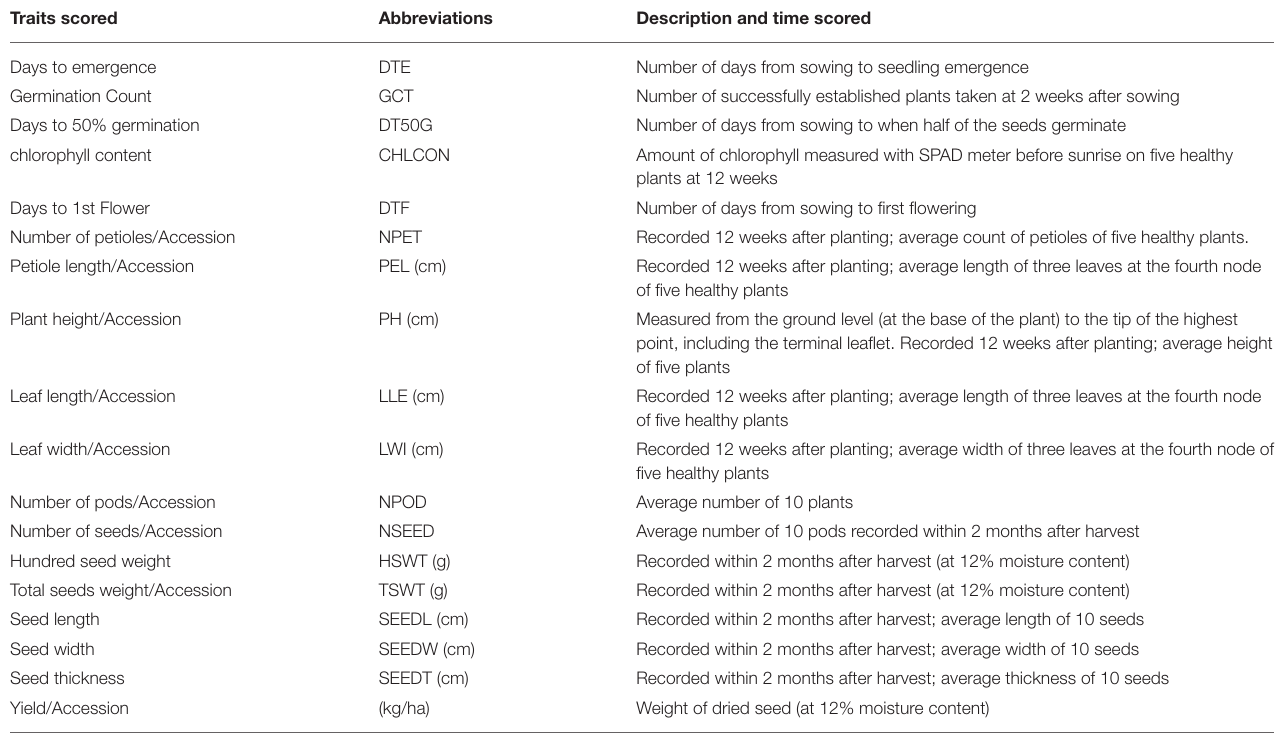
TABLE 2 | Traits scored and their abbreviations. Traits scored